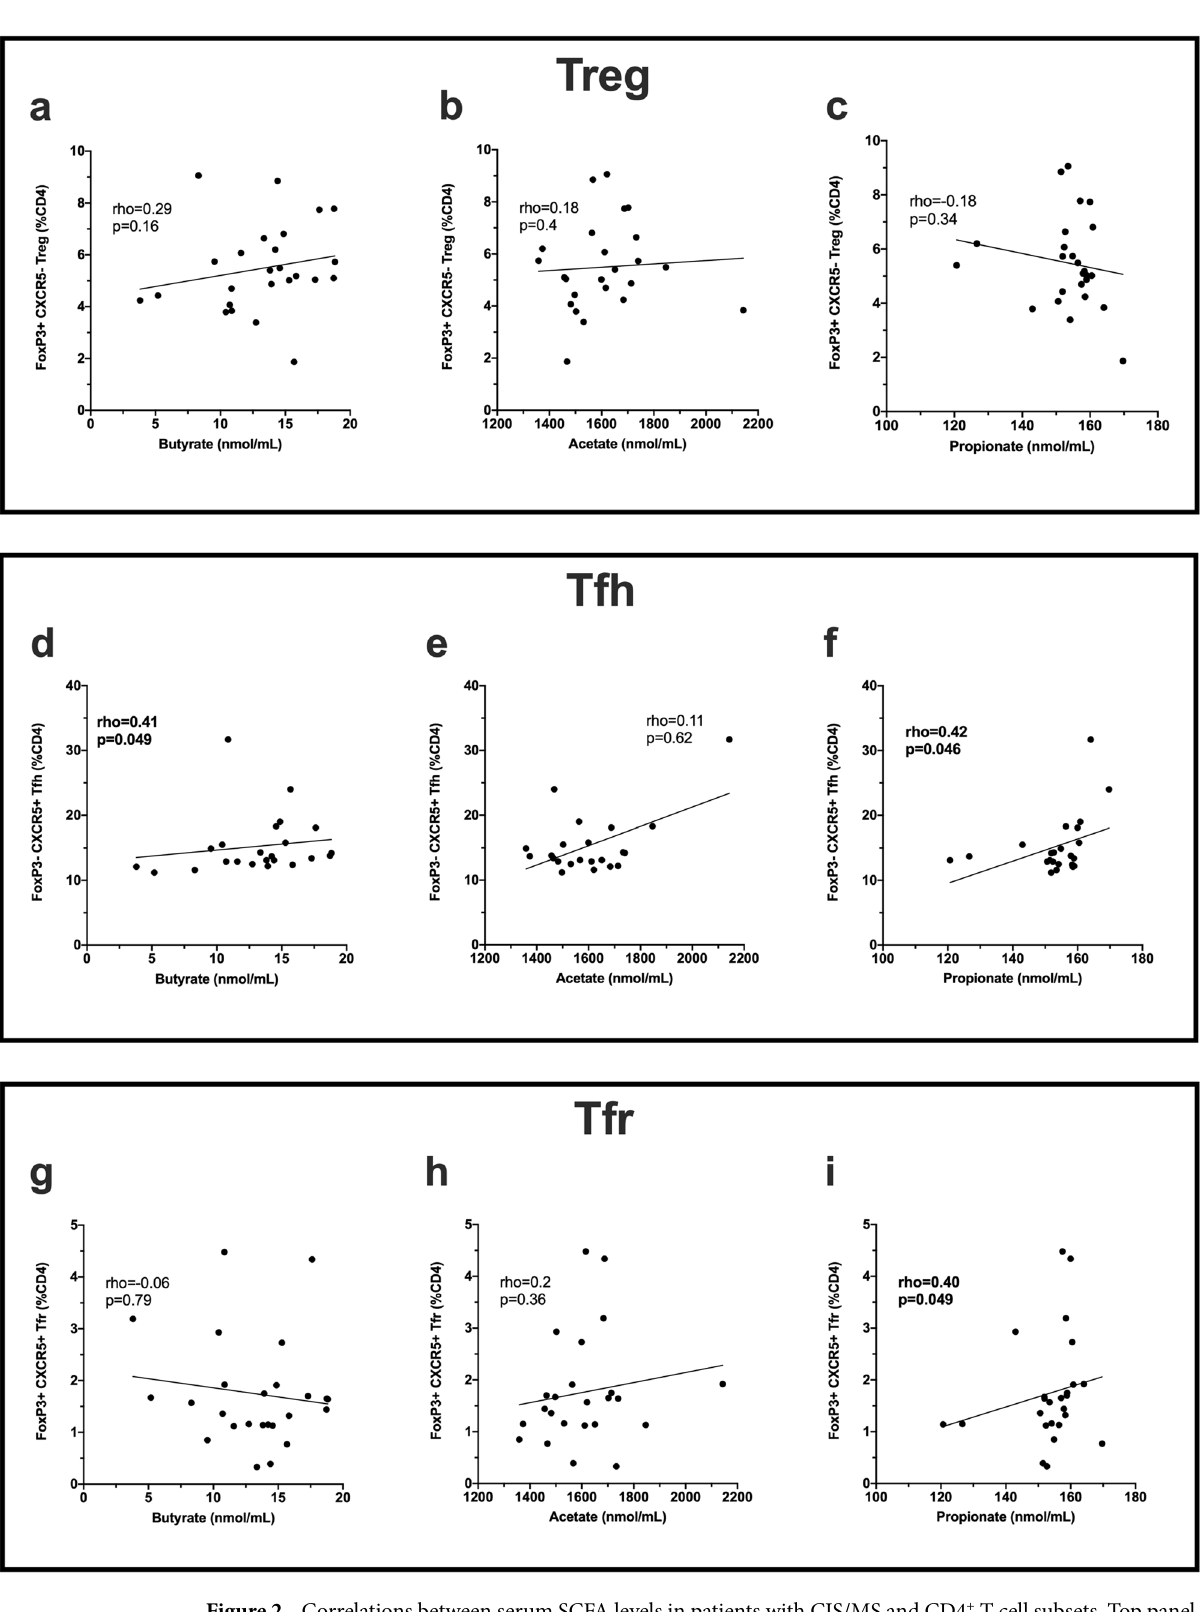
Figure 2. Correlations between serum SCFA levels in patients with CIS/MS and CD4 + T cell subsets. Top panel shows T regulatory cells (Treg; CD4 + Foxp3 + CXCR5 − ; n = 25), middle panel shows T follicular helper cells (Tfh; CD4 + CXCR5 + ; n = 23), bottom panel shows T follicular regulatory cells (Tfr; CD4 + Foxp3 + CXCR5 + ; n = 25), and their correlation with (a,d,g) butyrate, (b,e,h) acetate and (c,f,i) propionate levels in serum. Statistical comparisons were made with nonparametric Spearman’s correlation; rho values and p values are shown. Linear regression line is shown for illustrative purposes only. Statistically significant p values are shown in bolded